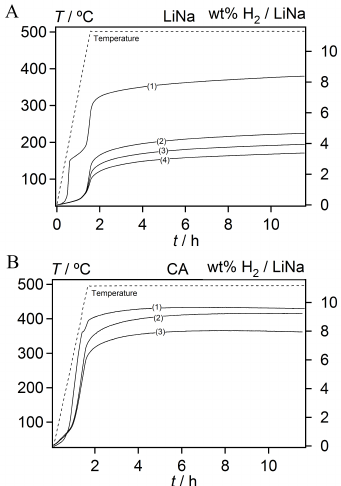
Figure 3. Sieverts’ measurement showing four and three hydrogen release cycles for ( A ) bulk 2LiBH 4 -NaAlH 4 and ( B ) infiltrated into CA, LiNa-CA. Hydrogen desorption was performed at a fixed temperature of 500 °C ( Δ T / Δ t = 5 °C) for 10 h under an initial hydrogen pressure of 1 bar. Hydrogen absorption was performed at 400 °C, p (H 2 ) = 126 bar for 10 h.